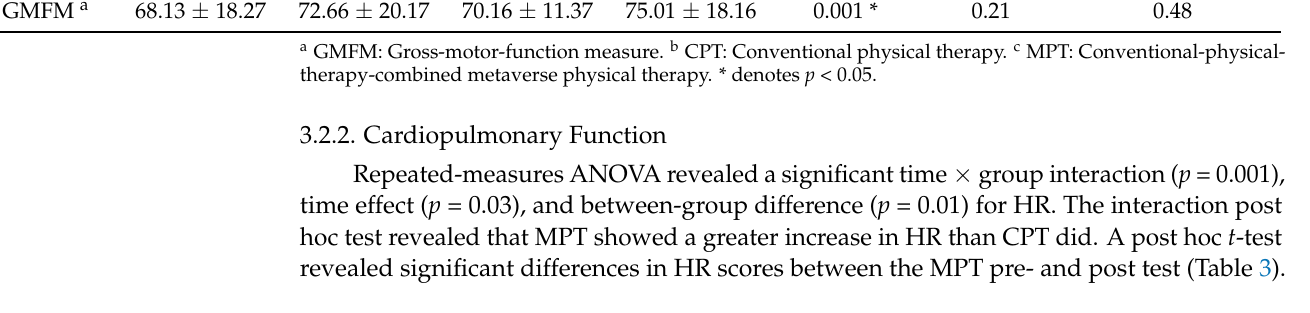
Table 3. Cardiopulmonary